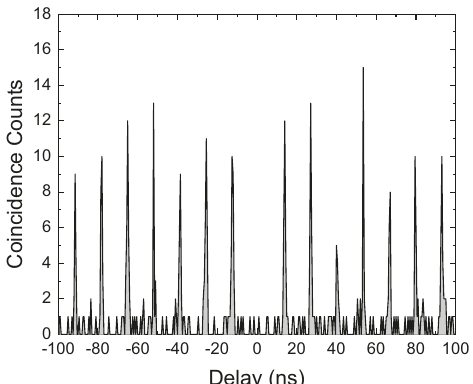
Fig. 5 g (2) -measurement of SDC emission. Histogram of the pulsed correlation measurement. Because of the weak SDC intensity an integration time of 118 h has been used. The central peak is virtually missing (g (2) ( t = 0) < 0.1), indicating true single photon